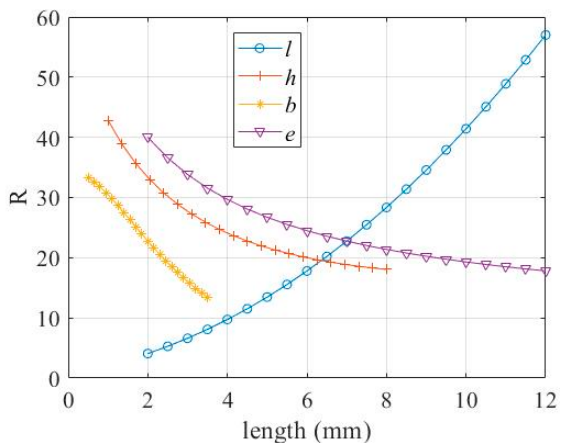
Figure 9. Relationship between R and h , l , e , b.